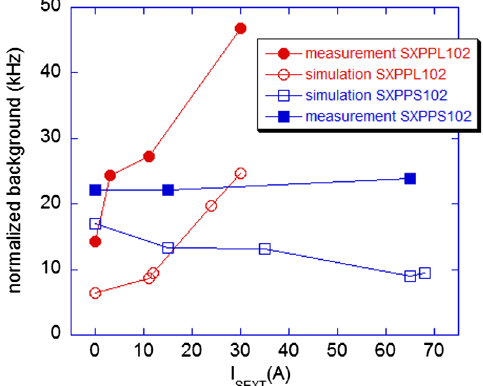
FIG. 9. Normalized background (kHz) measured by the KLOE EmC as a function of the strength of two sextupoles (full markers), compared to calculations (empty